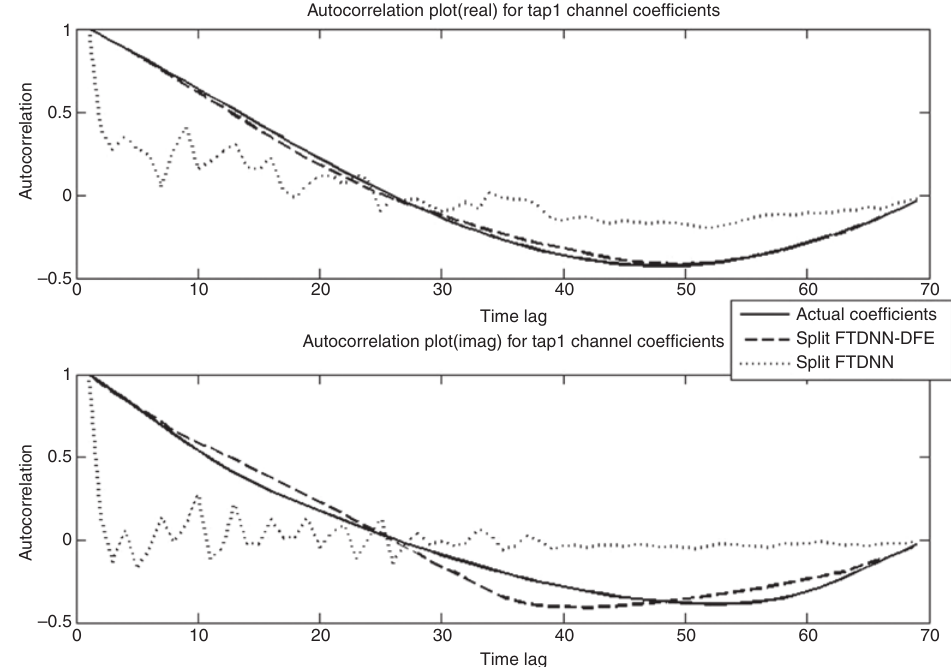
Figure 14: Autocorrelation Plot for Case 1.